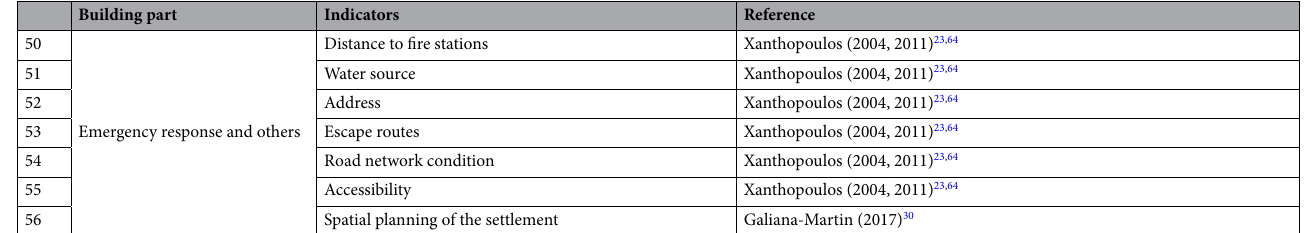
Table 7. Factors related to the physical vulnerability of buildings to wildfire from the literature. *Indicators used also in the present